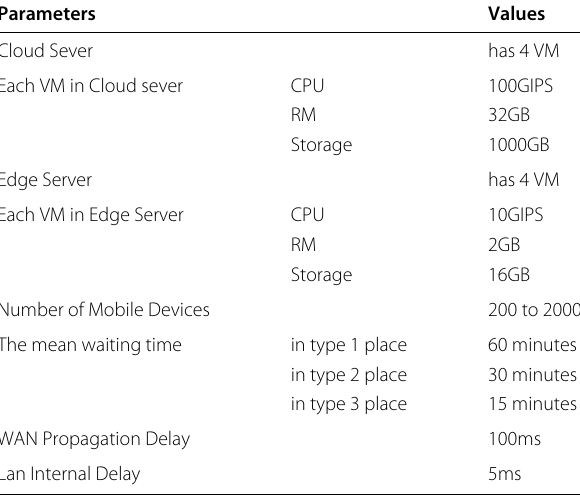
Table 1 the related parameters in simulations